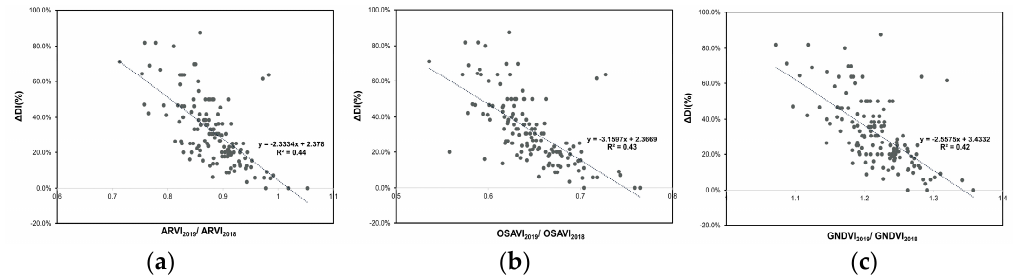
Figure 10. Relationship between ΔDI and temporal rate of change in VIs: ARVI (a), OSAVI (b), GNDVI (c).